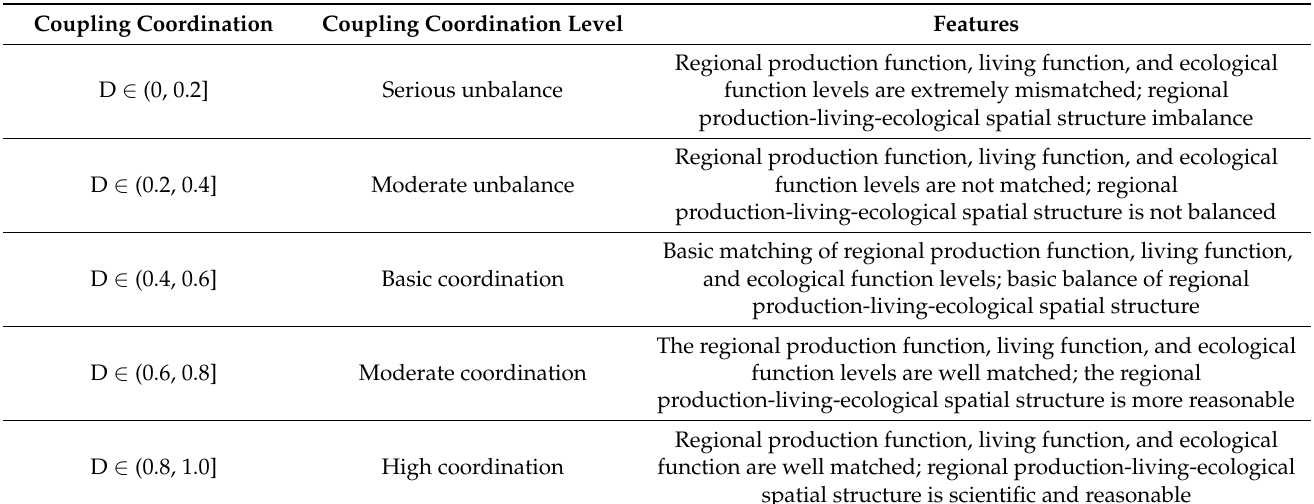
Table 2. Classification of production-living-ecological spatial function coupling coordination degree types in the Yellow River